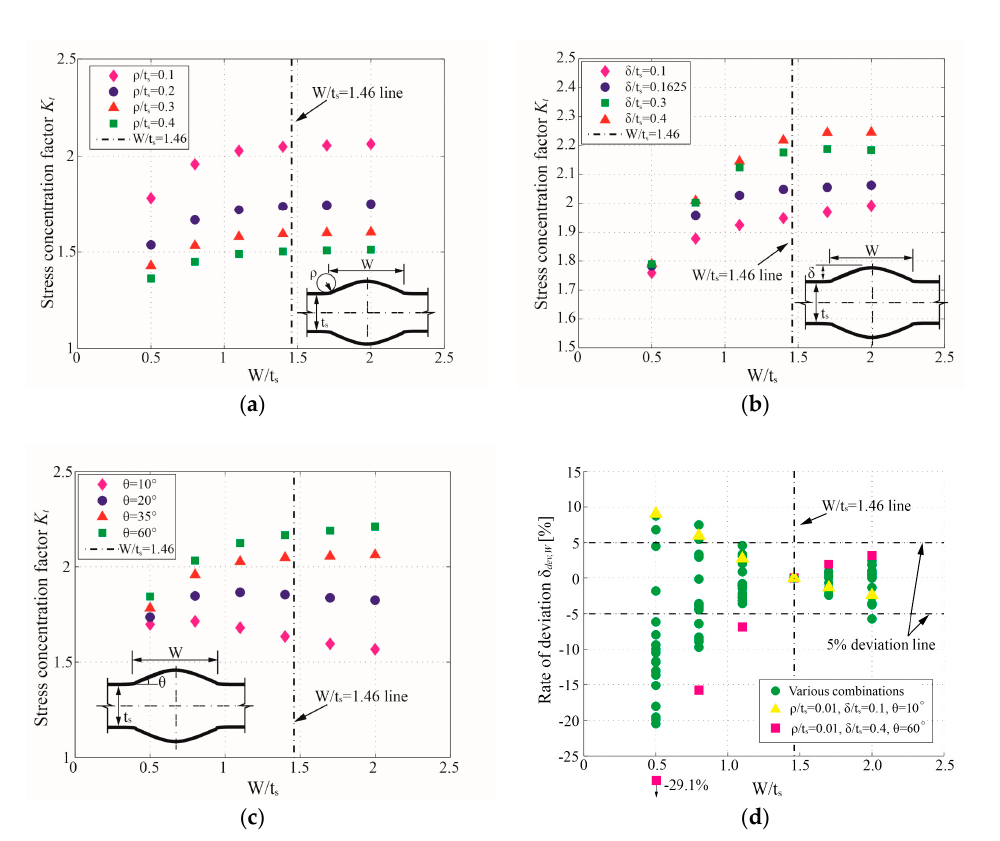
ρ / t s , constant t ): ( a ) FE results under various s = 0.1